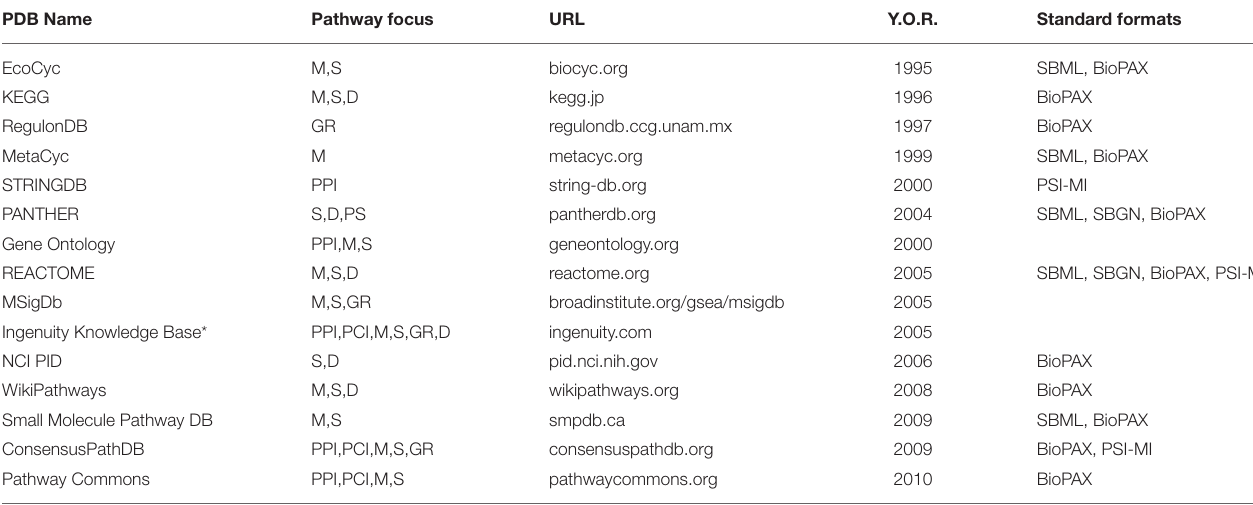
TABLE 1 | Pathway